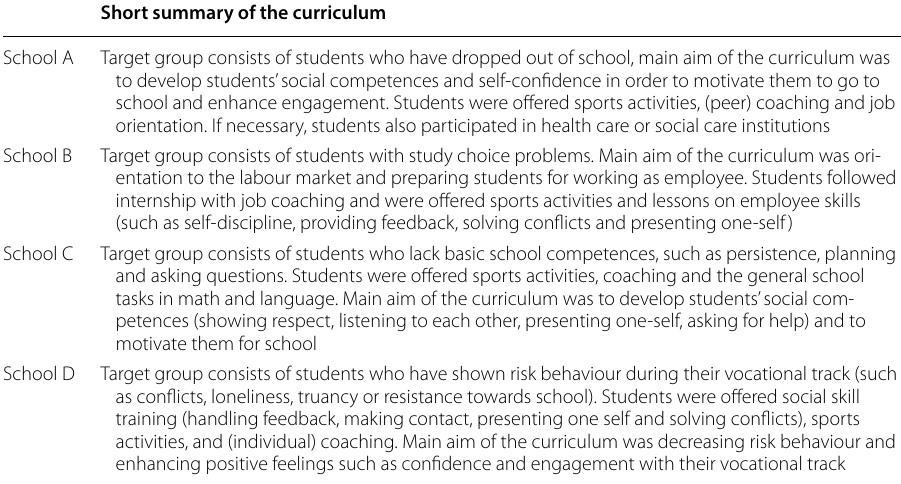
Table 2 Brief description of the curriculum per school Short summary of the